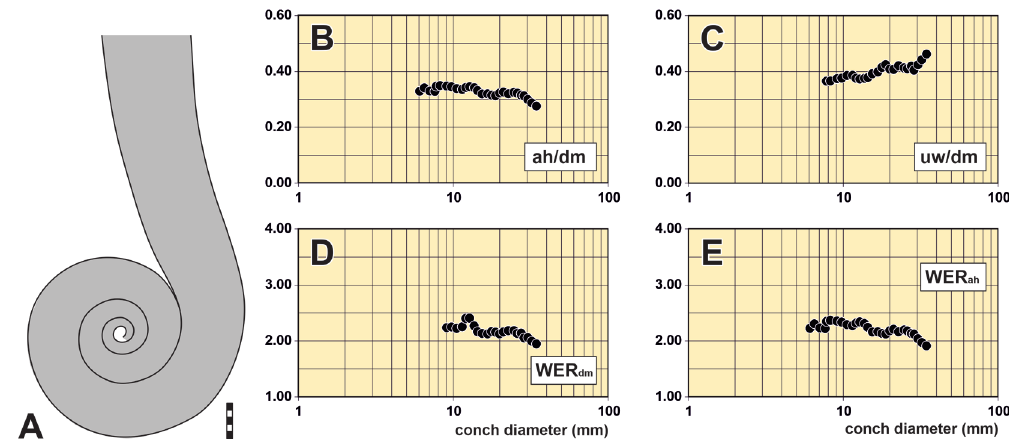
Fig. 59. Lituites clavis sp. nov. A . Outline of coiled conch part of holotype MB.C.30537. B–E . Conch proportions and coiling rates of holotype MB.C.30537. Scale bar units = 1 mm.